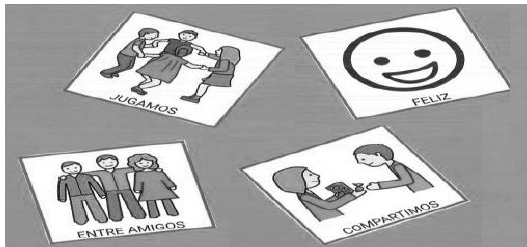
Figure 2. In this quotation graphic, a primary SOC student offers a positive assessment towards his classmates in the reference classroom when present with them. This indicates that they are all friends and that they are happy being together.